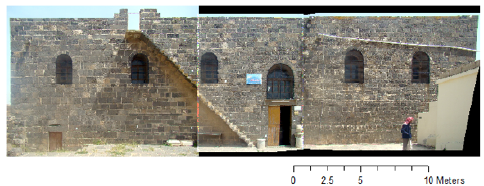
Figure 7. Photomosaic of Al Omari Mosque